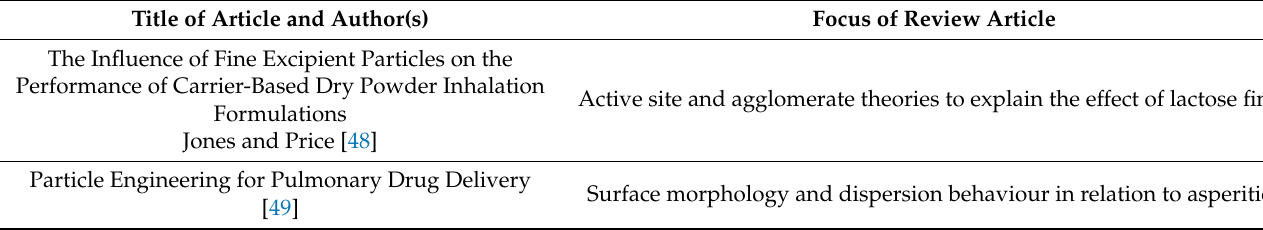
Table 1. Major literature reviews on optimisation of carrier-based DPI formulation